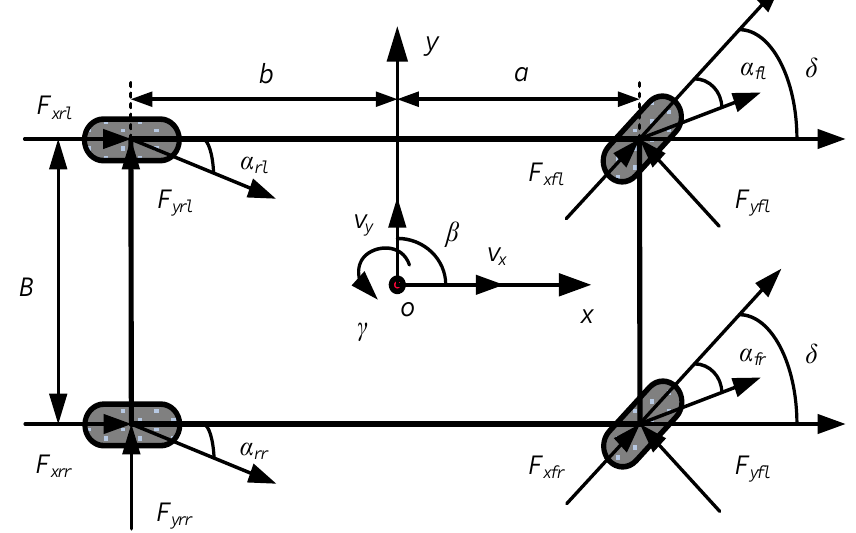
Figure 2. Seven-degrees-of-freedom vehicle model.